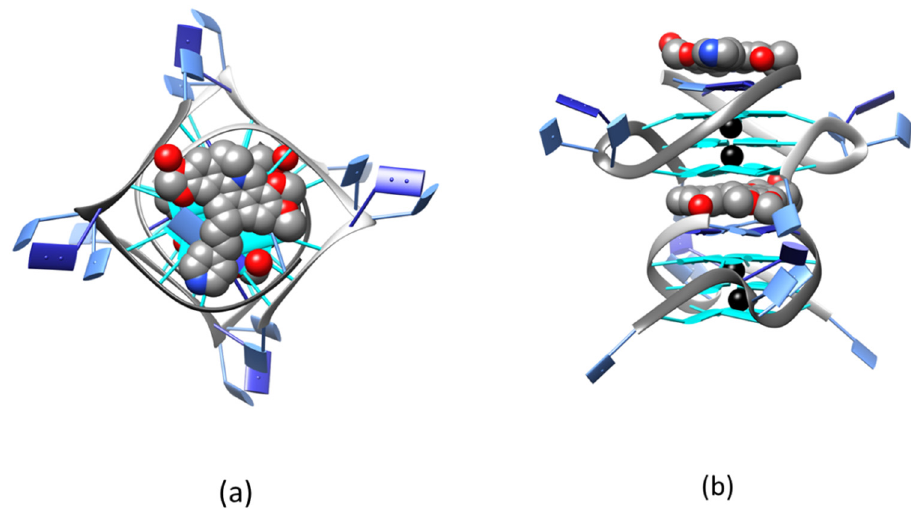
Figure 3: 4 /Tel12 crystal structure—1:1 ligand/quadruplex adduct organized in columns growing along the c axis: ( a ) top view; ( b ) lateral view. Only one symmetry-related position is shown for 4 , depicting water molecules and disordered K + ions (color code: G = cyan, A = blue, T = light blue, potassium ions = black, ligand and water atoms = by element).